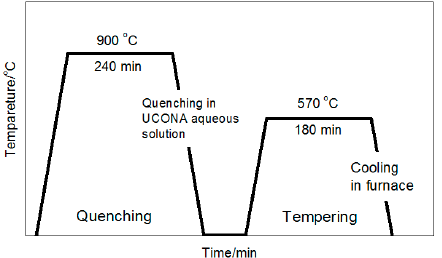
Figure 1. Schematic process of heat treatment for the ductile iron wheel.